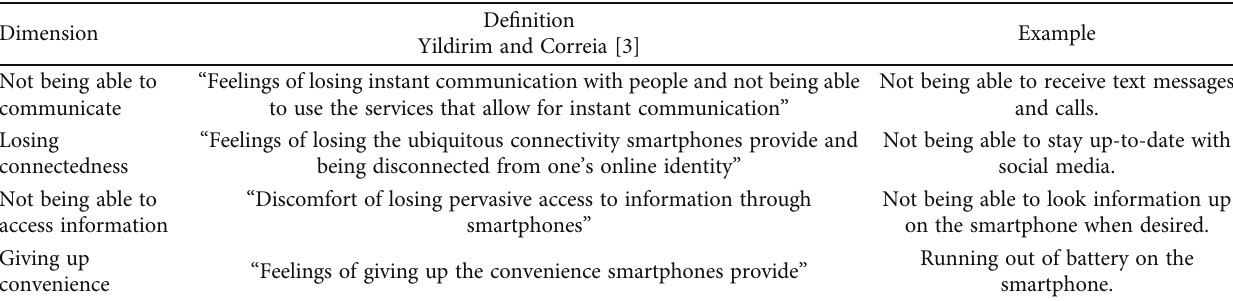
Table 1: Four dimensions of Nomophobia in NMP-Q instrument.